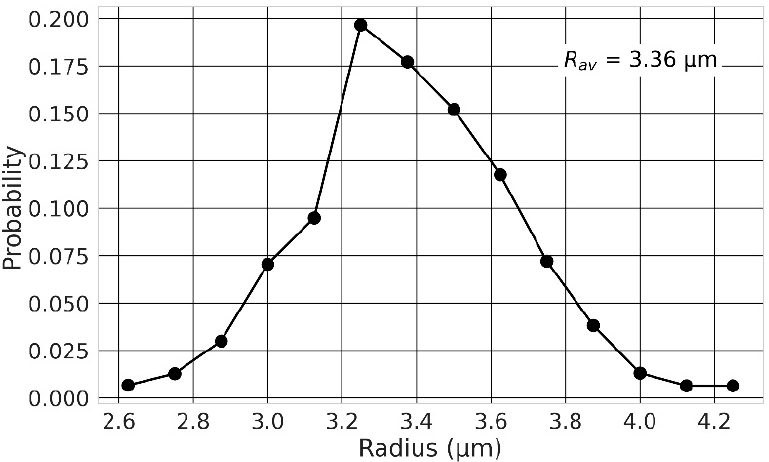
Figure 3. Probability distribution of lymphocyte nuclear radii. Adapted with permission from Ref. [26] © 2006, Elsevier. The average nuclear radius is 3.36 μ m assuming a spherical distribution.